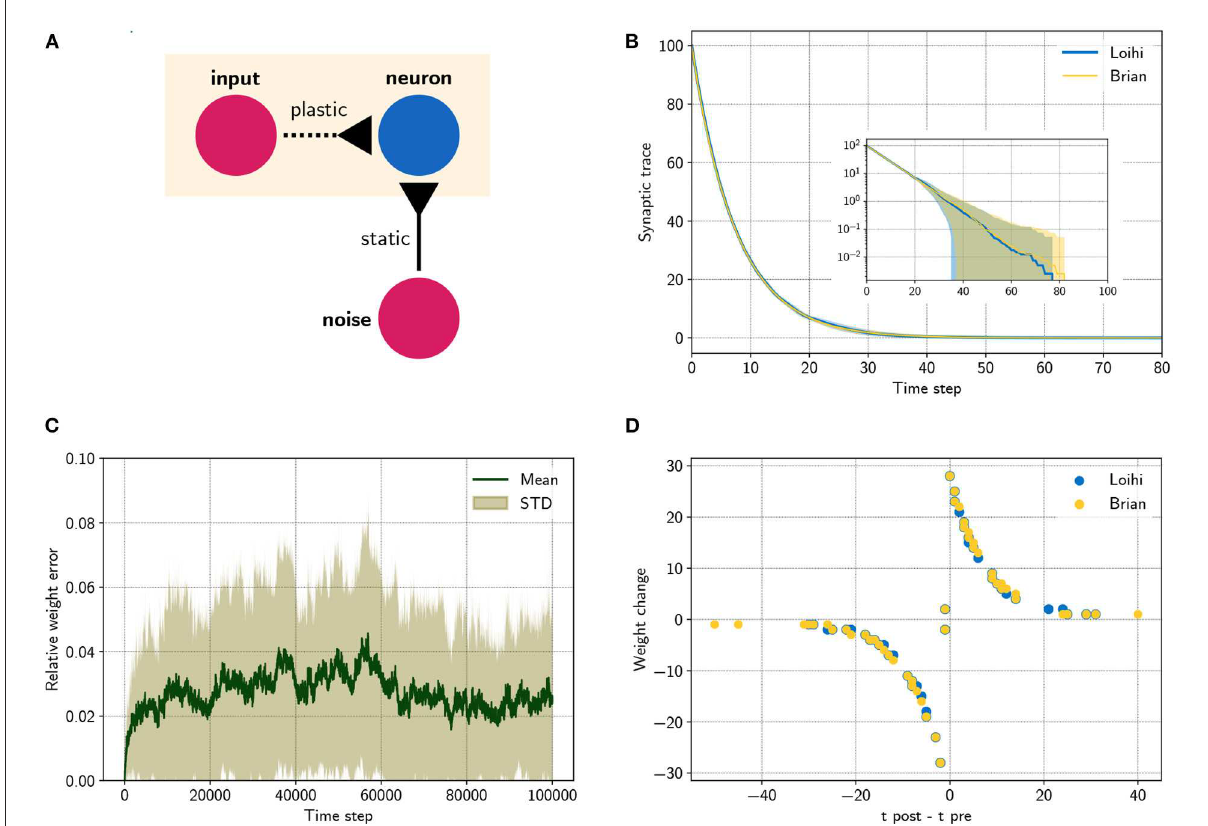
FIGURE2 Comparing a STDP learning rule performed with the emulator and with Loihi . (A) Sketch showing the setup. (B) Synaptic trace for many trials showing the arithmetic mean and standard deviation. The inset shows the same data in a logarithmic scale. Note that every data point smaller than 10 0 shows the probability of rounding values between 0 and 1 up or down. (C) Relative difference | ˜ w L − ˜ w B | / ˜ w max for the plastic weight between the emulator, ˜ w B , and the Loihi implementation, ˜ w L , for 50 simulations, ˜ w max = 255. (D) STDP weight change in respect to pre- and post-synaptic spike times, data shown for time steps 0 − 2,000 for visualization